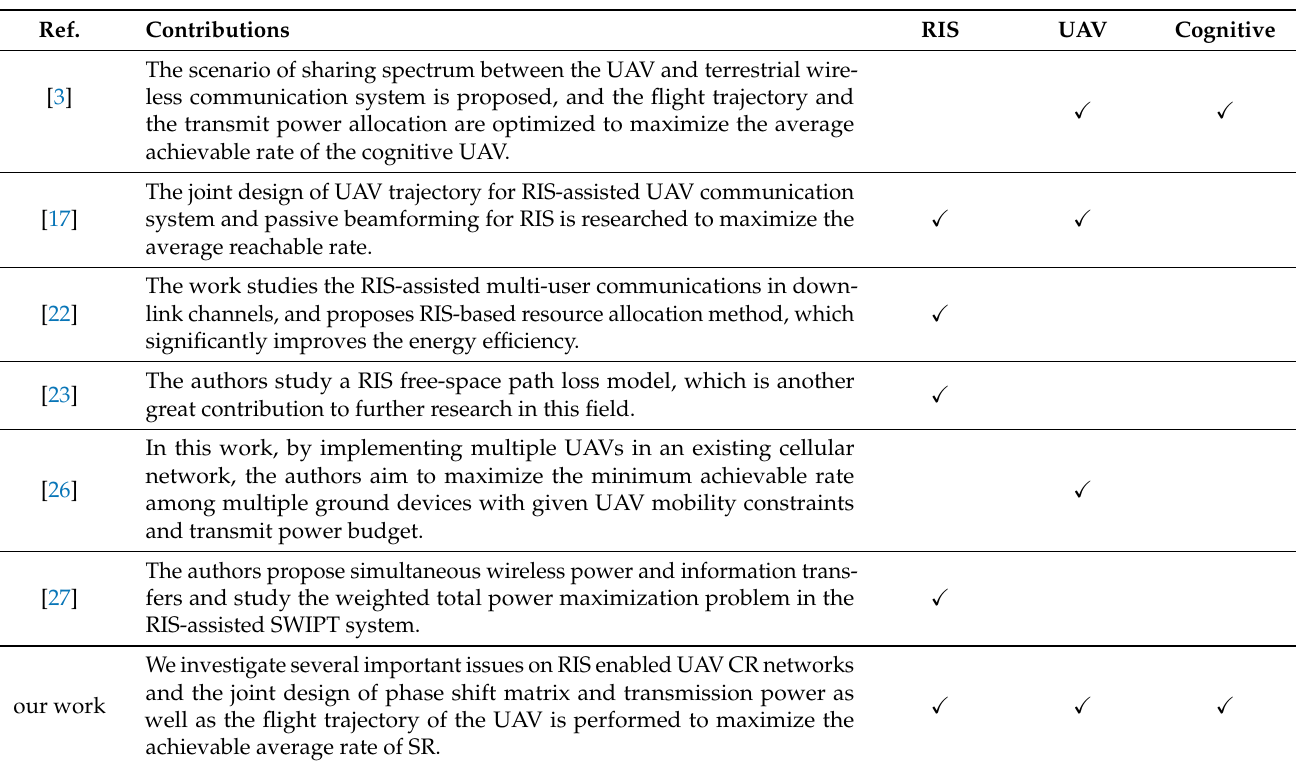
Table 1. Some existing